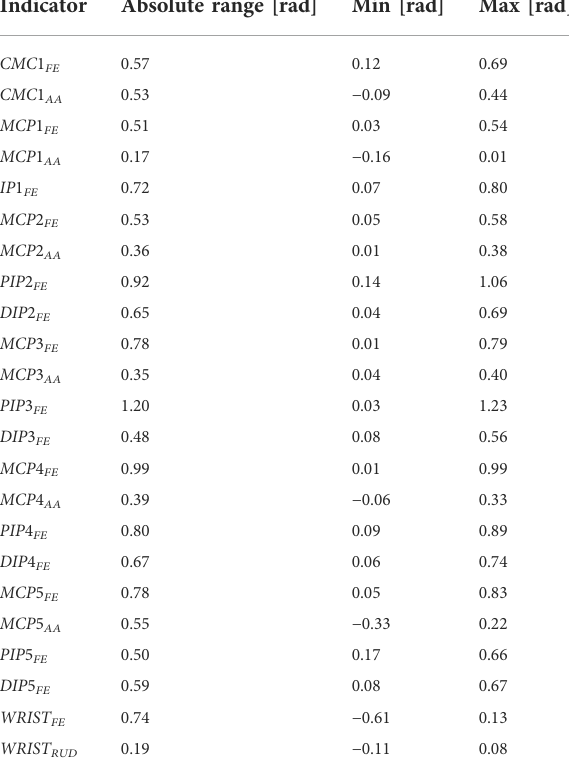
TABLE 3 Computed Indicators regarding the angle range.